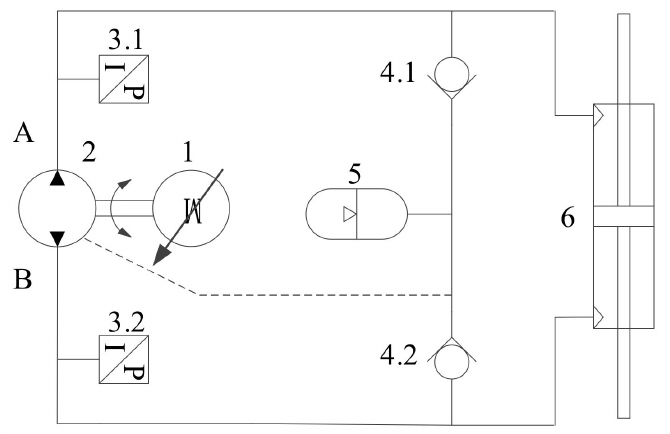
Figure 20. Hydraulic schematic of the friction characteristics test of pump-controlled hydraulic cylinder.